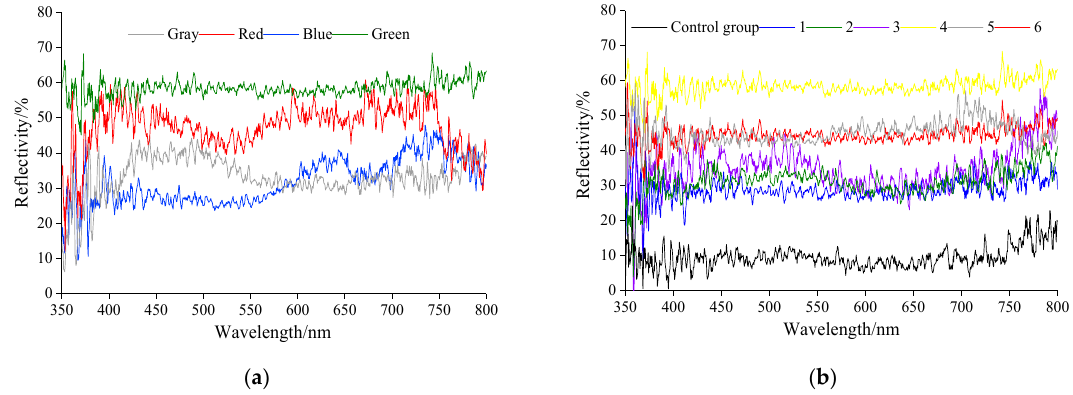
Figure 11. The reflectivity of the coating: ( a ) Reflectivity of different color coatings; ( b ) Reflectivity of coatings with different ratios.